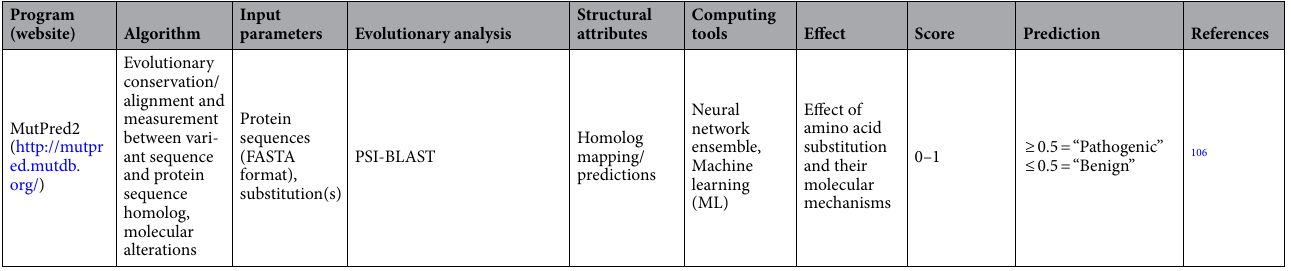
Table 1. Description of the functional prediction